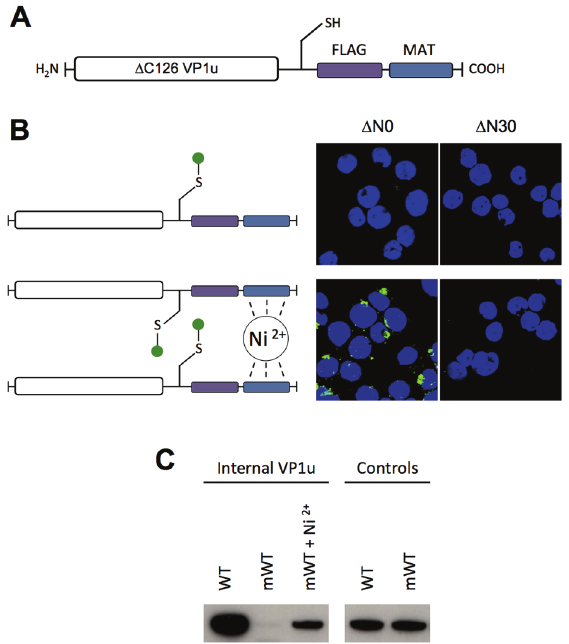
Figure 4. Internalization of VP1u monomer and dimer. ( A ) Recombinant ∆ C126 VP1u with unique cysteine (-SH) for specific crosslinking with maleimide-fluorescein; ( B ) Schematic depiction of fluorescein-labeled ∆ C126 VP1u (left), which was internalized into UT7/Epo cells and detected by fluorescence microscopy (right). Fluorescein-labeled ∆ N30/ ∆ C126 VP1u was used as a negative control; ( C ) Western blot of internalized WT VP1u (WT), monomeric C228G VP1u (mWT), and monomeric VP1u supplemented with 10 µM Ni 2+ . Controls show the relative input of WT and mWT in the internalization experiment.